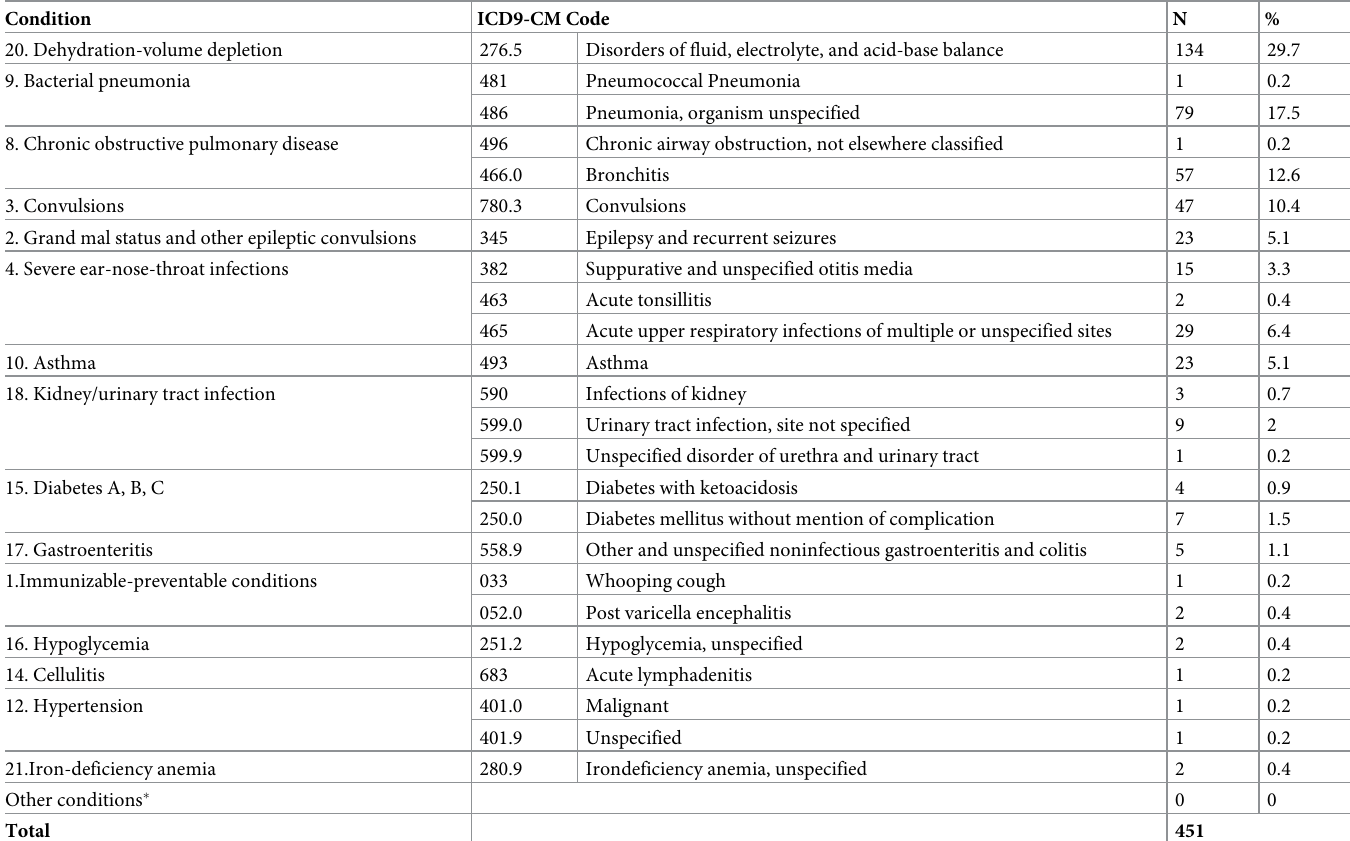
Table 1. Frequency of specific preventable hospitalization conditions in the study